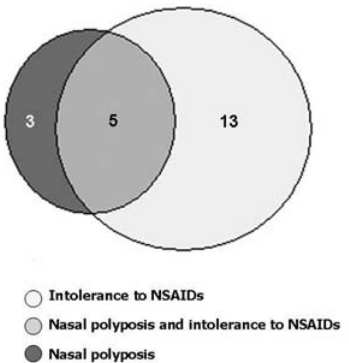
Figure 3 – Frequency of intolerance to nonsteroidal anti-inflammatory drugs (NSAIDs) and nasal polyposis. (cid:1) White color represents intolerance to NSAIDs; (cid:2) Black color represents nasal polyposis